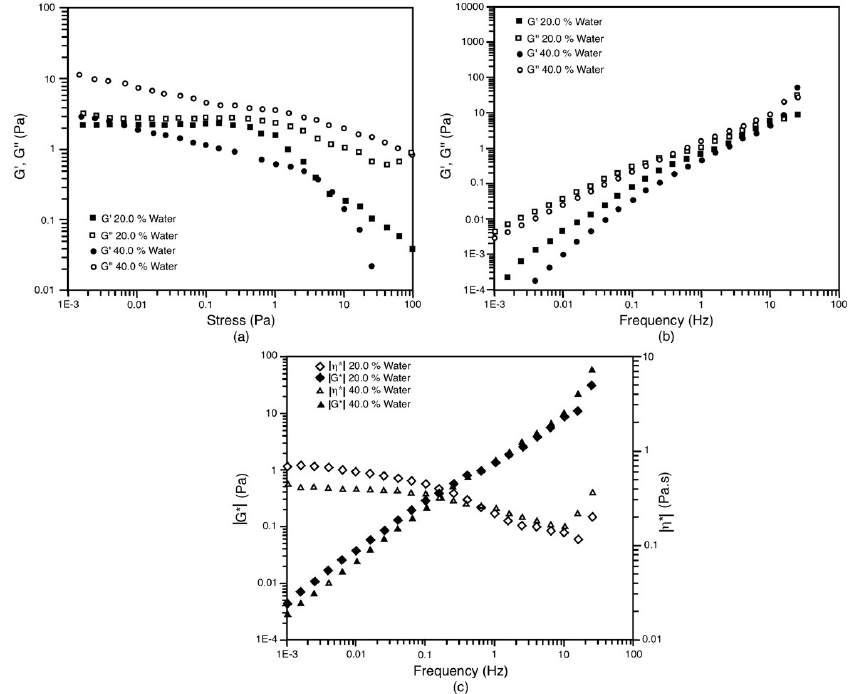
Figure 10. Oscillatory tests for the system with the dilution line S/O = 25/75 at 30 °C. The liquid crystal is in equilibrium with the oil phase and the Om and Wm phases in the case of 20% and 40% of water, respectively. ( a ) Amplitude shear stress sweep at 1 Hz; ( b ) Frequency sweep at 0.1 Pa; ( c ) Evolution of |G*| and |η*| against frequency.